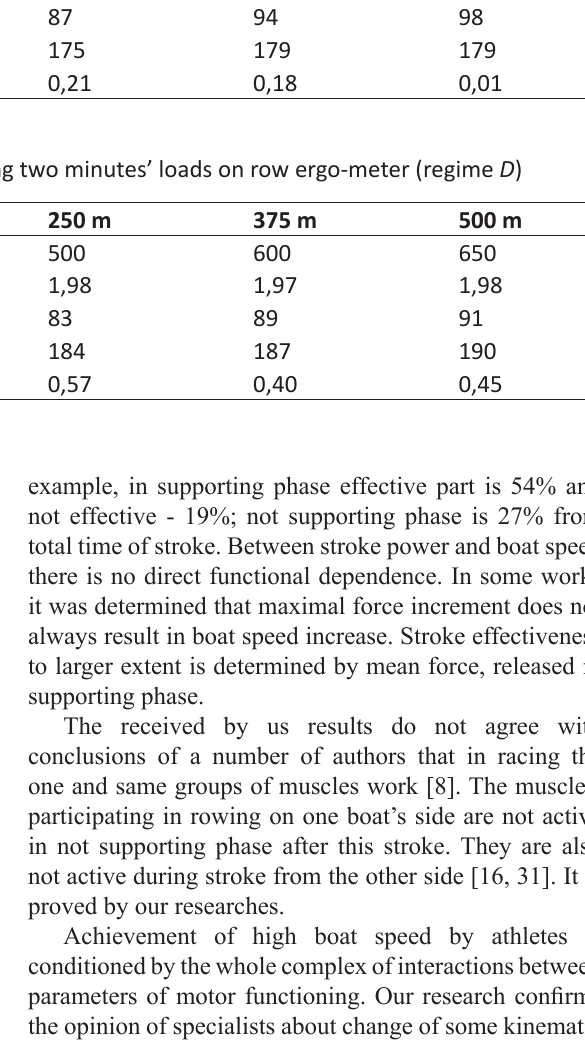
Table 4. Bio-energetic indicators of athletes, when fulfilling two minutes’ loads on row ergo-meter (regime B ) Indicators